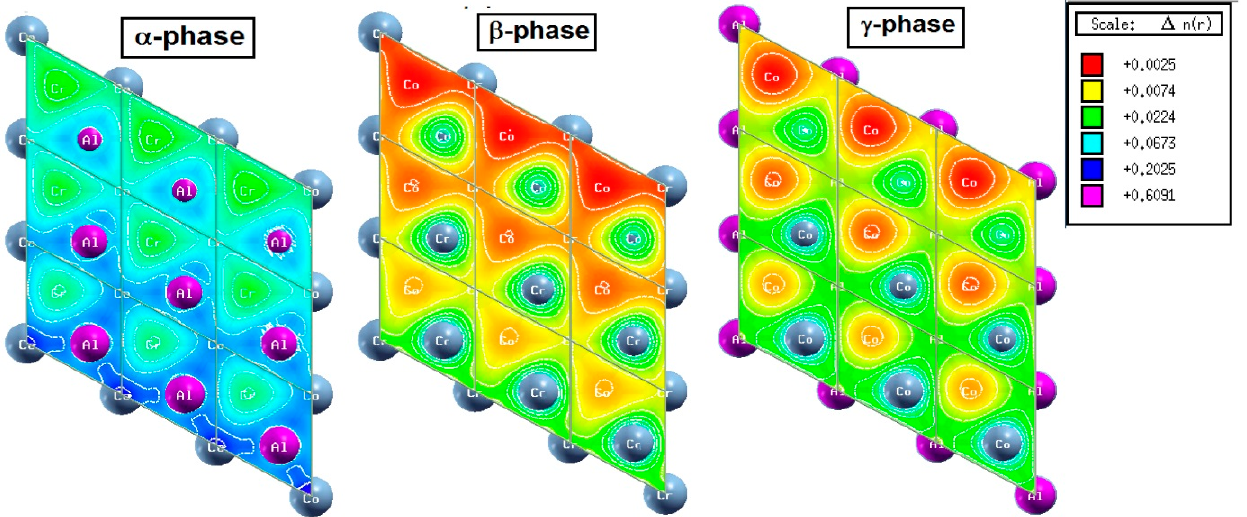
Figure 7. Three Heuslerene monolayers of Co 2 CrAl, named α , β and γ . The difference arises from the termination of the surface atoms.